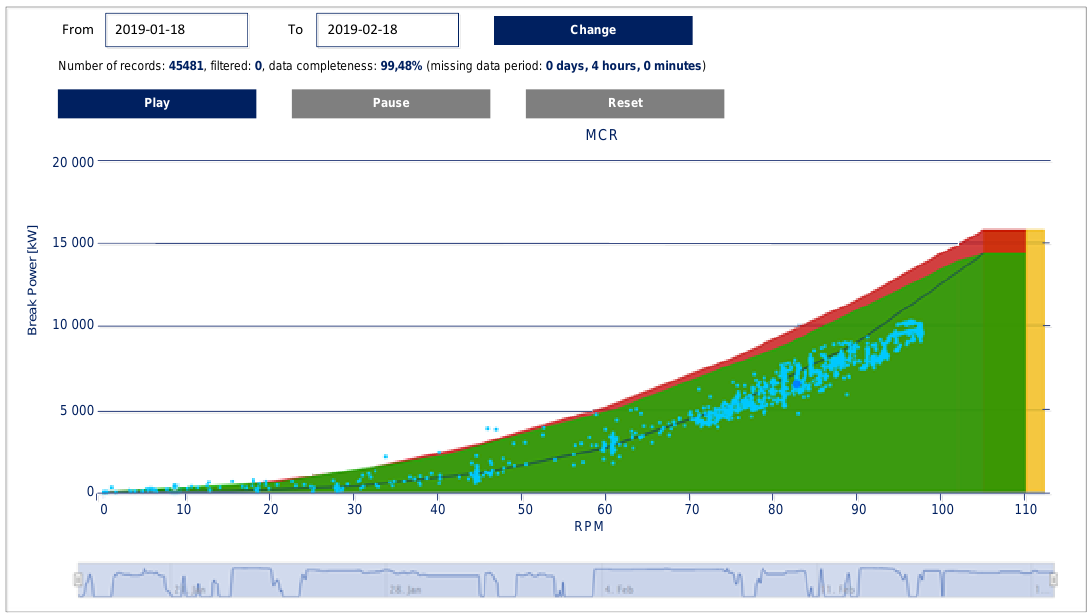
Figure 5. Main engine (ME) layout with actual operation points for one-month ship operation provided by SeaPerformer system; the records below the main engine layout present momentary changes of RPM on the ME shaft in the above-defined period (Courtesy of Enamor Ltd.).